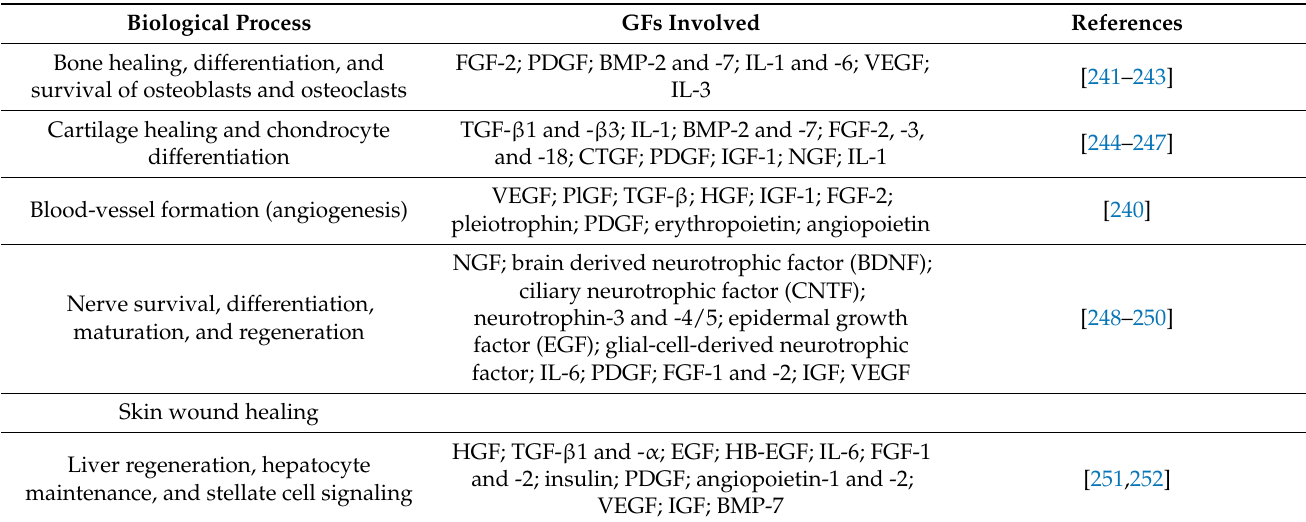
Table 2. Principal tissues and healing processes associated with the GFs associated with physical polysaccharide-based